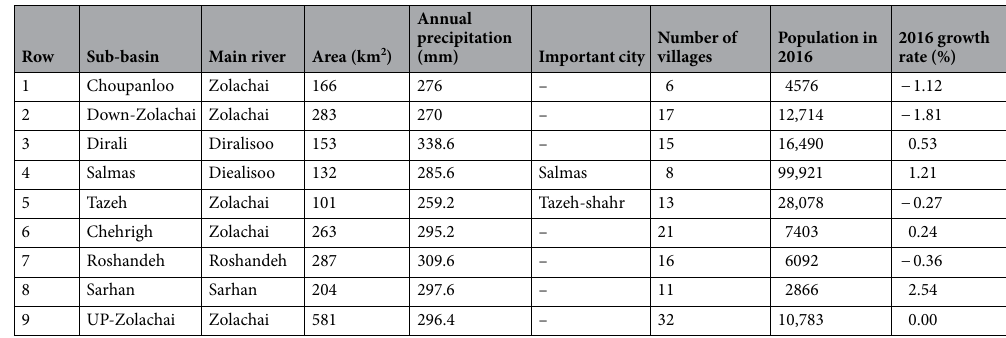
Table 1. Characteristics of the sub-basins of Zolachai basin.